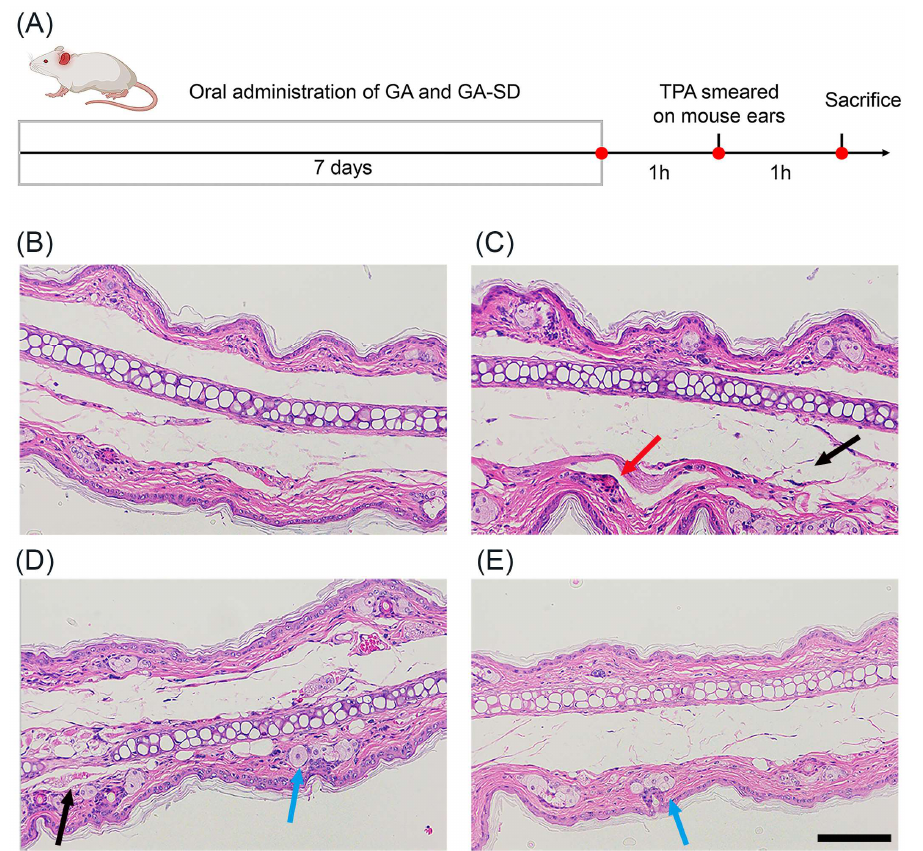
Figure 8. Histopathology of mouse ear in each experimental group. ( A ) Experimental scheme of TPA-induced mouse ear edema model. H&E staining of ear tissue slices after treatment with ( B ) PBS+ acetone, ( C ) PBS+TPA, ( D ) free GA+TPA, and ( E ) GA-SD+TPA. Scale bar: 100 µm. The black arrow marks the discrete rupture of the transverse muscle, the red arrow marks the small vessel congestion, and the blue arrow marks the inflammatory cell infiltration.